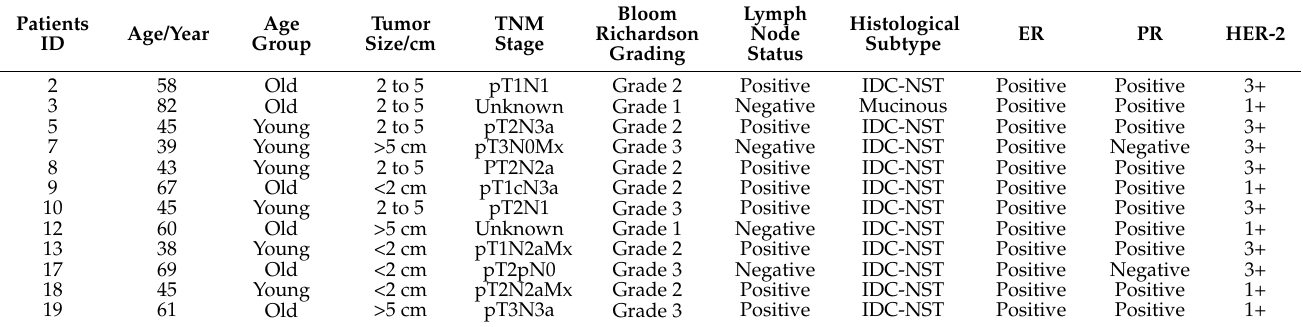
Table 1. Clinicopathological characteristics of breast cancer cases included in the gene expression study.